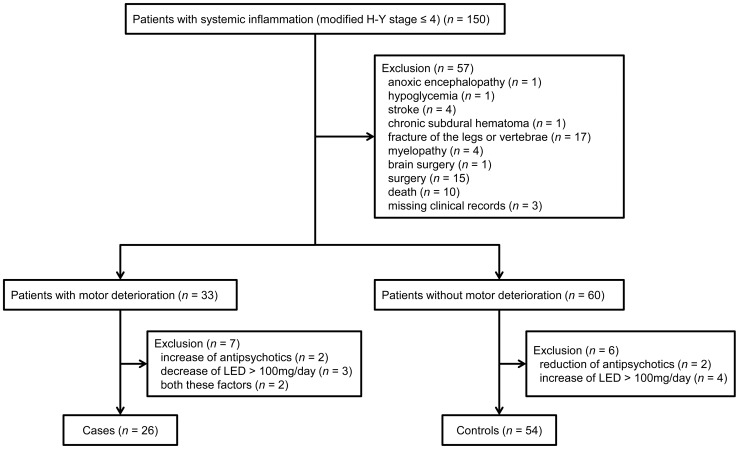
Flow diagram showing selection of eligible patients and the enrollment process.H–Y, Hoehn and Yahr; LED, L-DOPA equivalent dose.